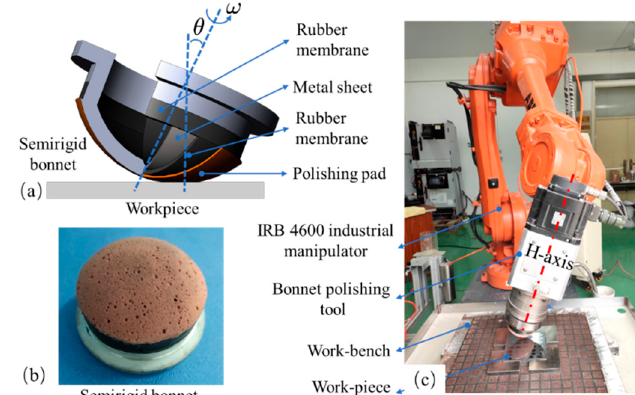
Figure 1. Experimental setup. ( a ) Structure of the semirigid (SR) bonnet; ( b ) photograph of the semirigid (SR) bonnet; ( c ) robot-assisted bonnet polishing system used in this study. LP-66 (Universal Photonics, NY USA) is pasted on the SR bonnet as a polishing pad. It is a high-performance, optical-level processing material with an elastic, soft surface, pores and a long service life [36]. During polishing, the porous and soft polishing pad can